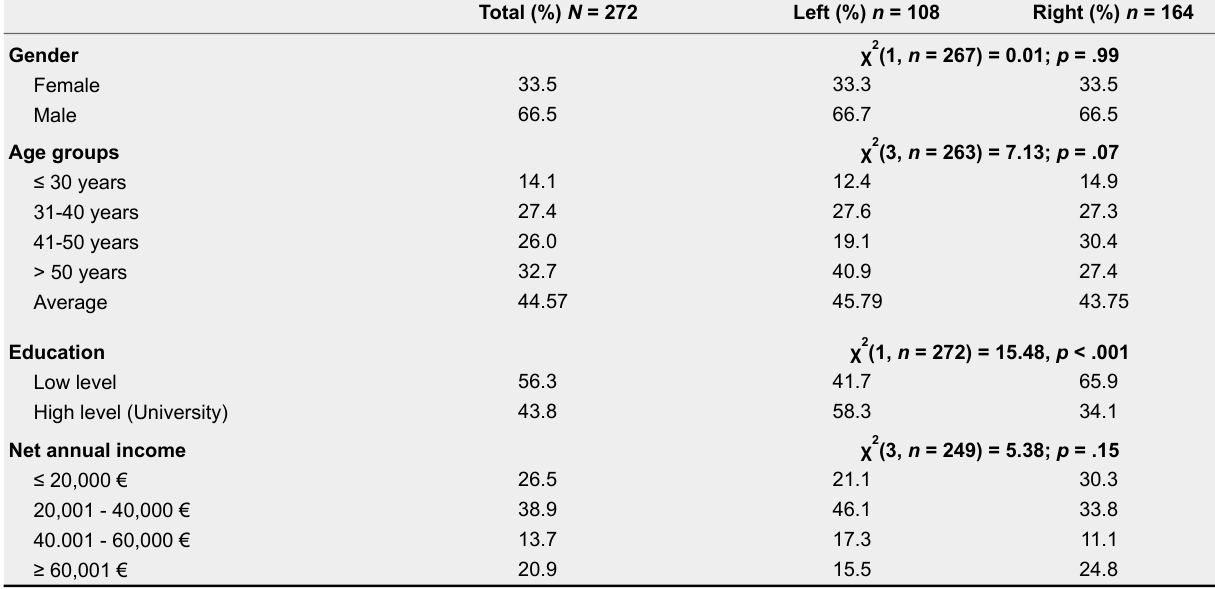
Right (%) n = 164Left (%) n = 108Total (%) N = 272